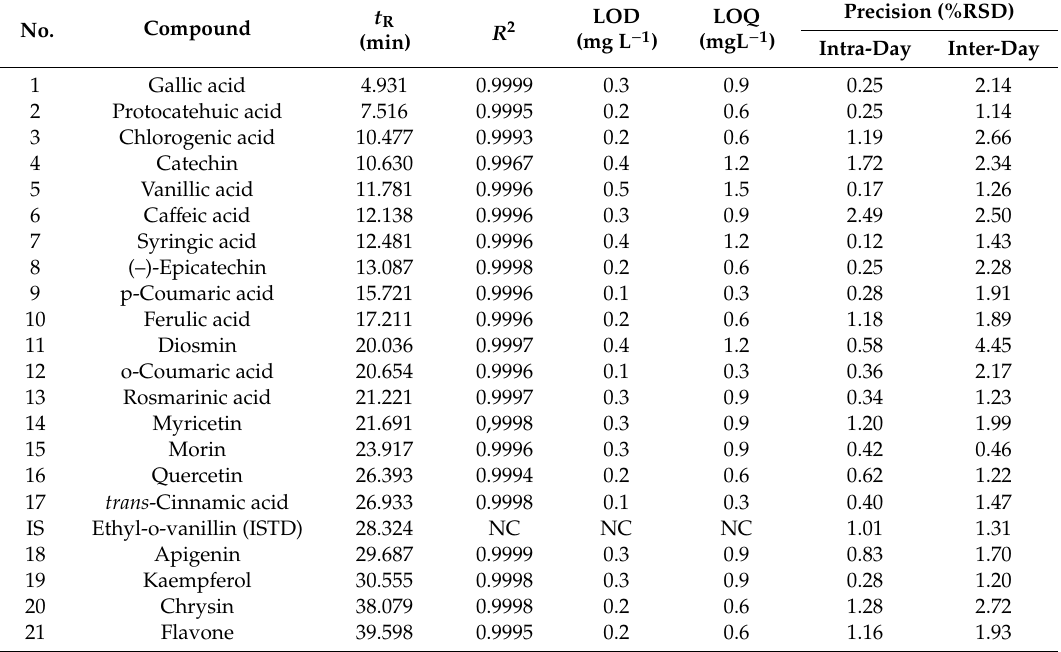
Table 3. Validation parameters for HPLC-DAD method: average retention time ( t R ); correlation coe ffi cient ( R 2 ); limit of detection (LOD); limit of quantification (LOQ); intra-day and inter-day precision